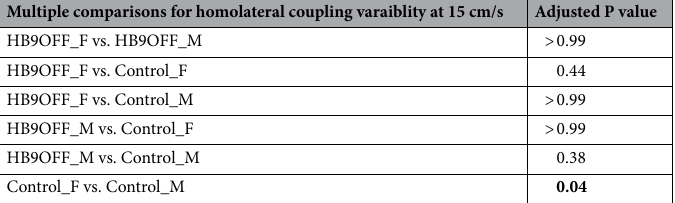
Multiple comparisons for homolateral coupling varaiblity at 15